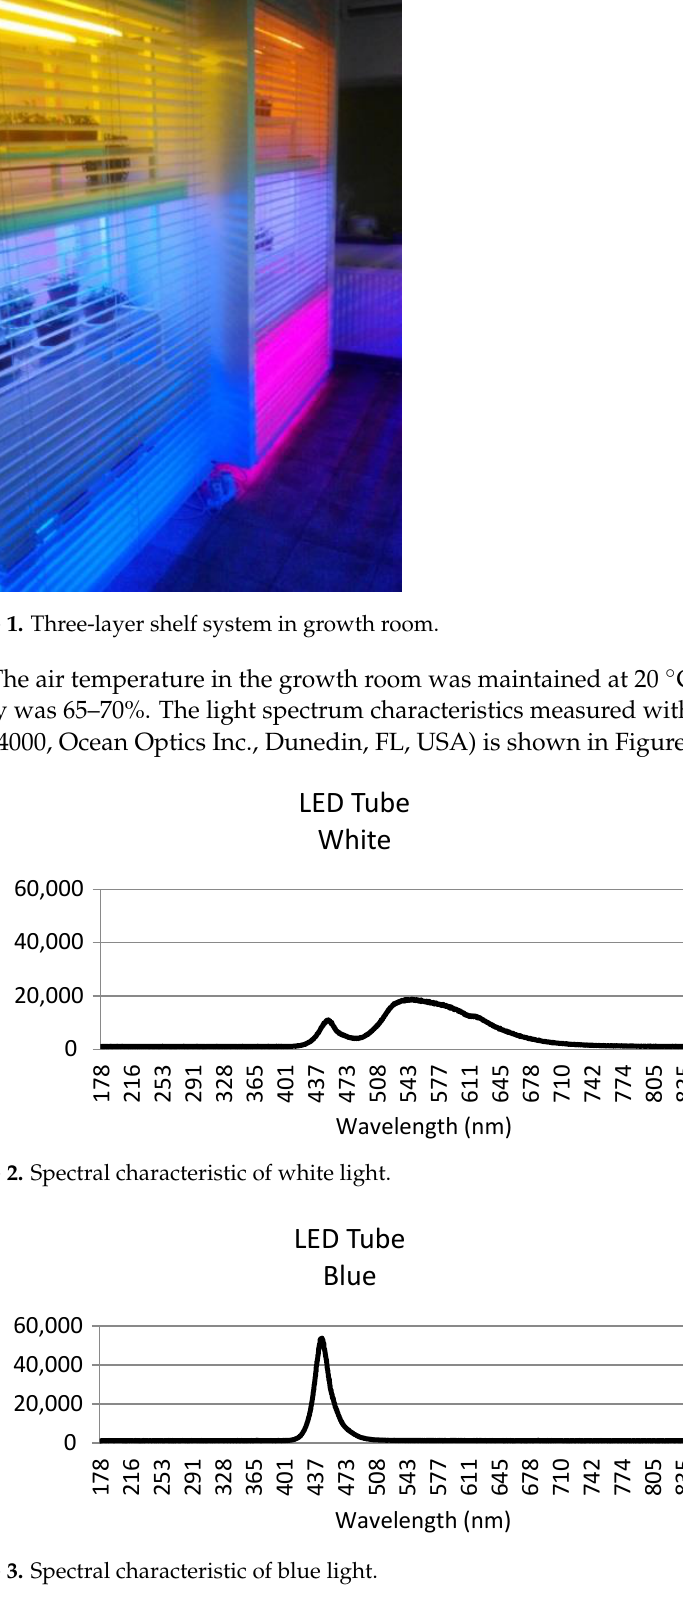
Figure 4. Spectral characteristic of white + blue light. Figure 5. Spectral characteristic of red + blue light. 2.2. Experimental Design The experiment was conducted in a completely srandomised design, where the ex- posure of the plants to different light colours was analysed, i.e., white light (W), blue light (B), red + blue light (RB), and white + blue light (WB). Rooted chrysanthemum cuttings were set in 4 treatments with 6 pots in each. There were 5 cuttings in each pot. The exper- iment was conducted at the Marcelin Experimental Station of the Faculty of Agricultural, Horticultural and Bioengineering Poznań University of Life Sciences, Poland, between July and November 2020. The following morphological traits of the plants were measured: the number of flower buds and flower heads, the diameter of the flower heads, the height of the plants,